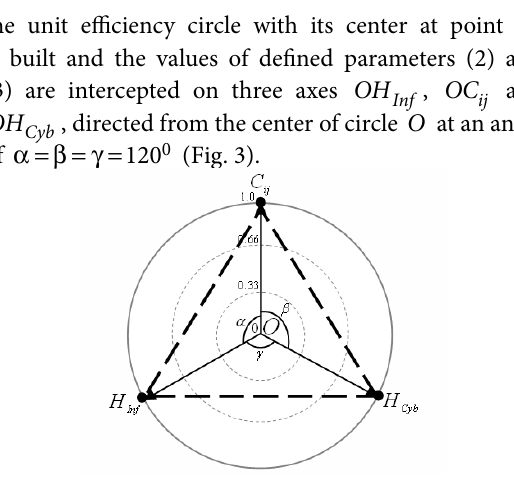
Fig. 3. Circular chart for synergistic effect assessment of the e - th element of the interaction matrix × ij